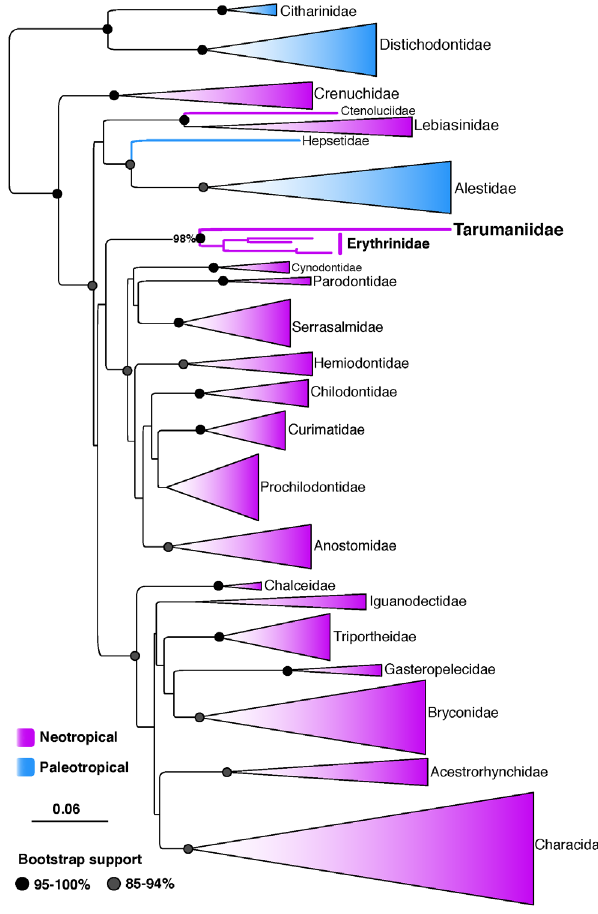
Fig. 1. Maximum likelihood tree resolving the phylogenetic placement of the family Tarumaniidae among 520 characi- form species. Scale bar = 0.06 expected substitutions per position as estimated by